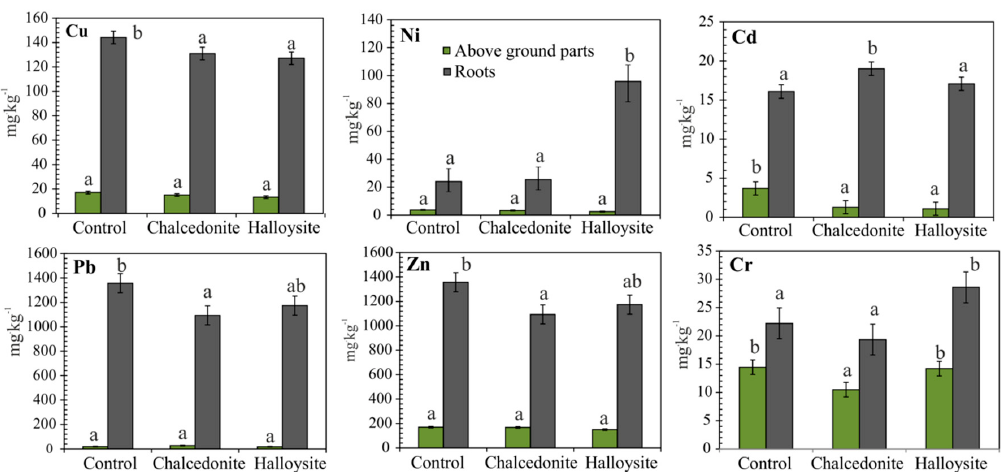
Figure 5. The effect of mineral ‐ based amendments on potentially toxic elements accumulation in the roots and above ‐ ground biomass of L. luteus. Error bars ± standard error ( n = 3). Different letters denote significant differences between treatments.